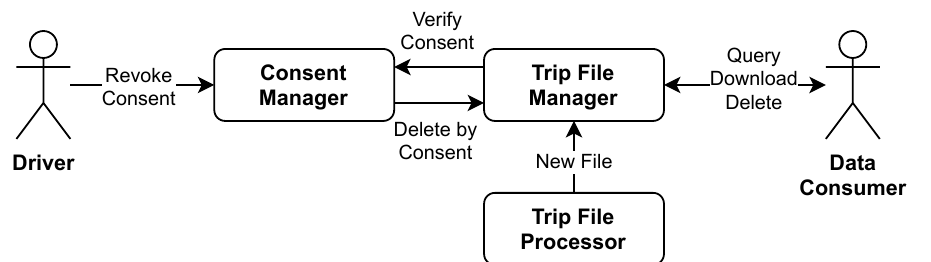
Figure 9. Interactions of the Trip File Manager with other system components or stakeholders. They may be performed concurrently and have the potential to cause